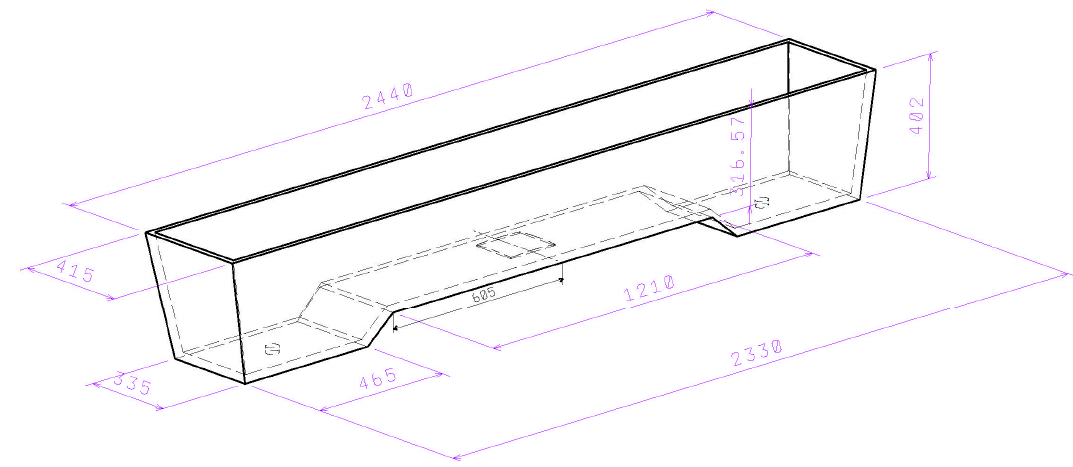
Figure 2. Position of the “Spheric“ impact pad in the tundish.